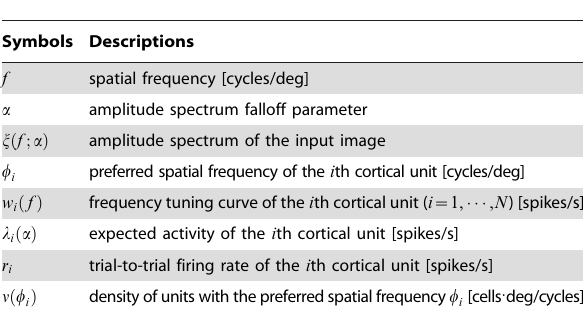
Table 1. Summary of the variables and the functions used in the